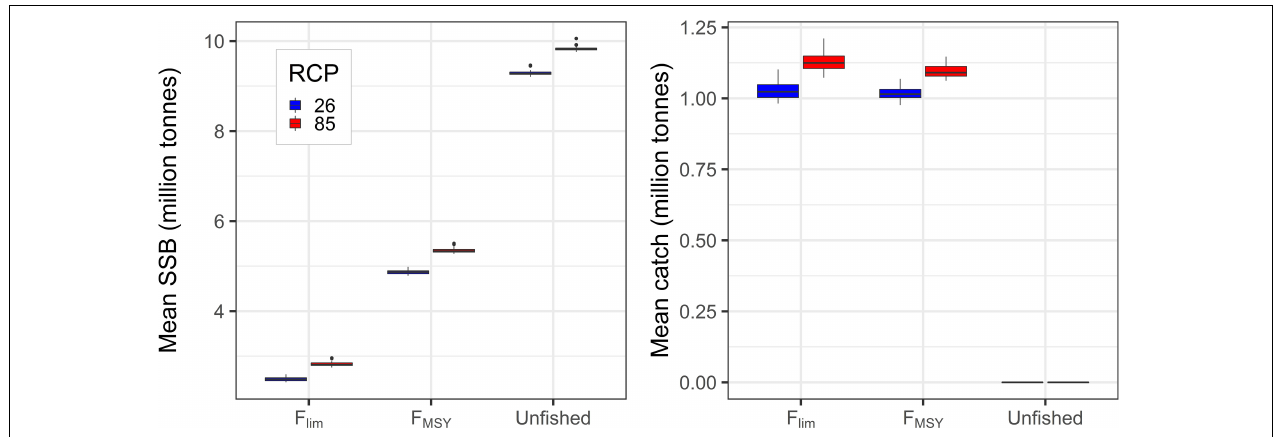
FIGURE 3 | Left: Mean SSB at spawning time over the period 2021–2050; and right: mean annual catch from the fishery over the same period. From left to right within each panel, boxes represent scenarios 1–6 ( Table 2 ). Within management scenarios the left-hand boxes correspond to RCP 2.6 and the right-hand boxes to RCP 8.5. Boxplots show medians and interquartile ranges, with the spread representing uncertainty in the parameter h and stochasticity in the IBM.